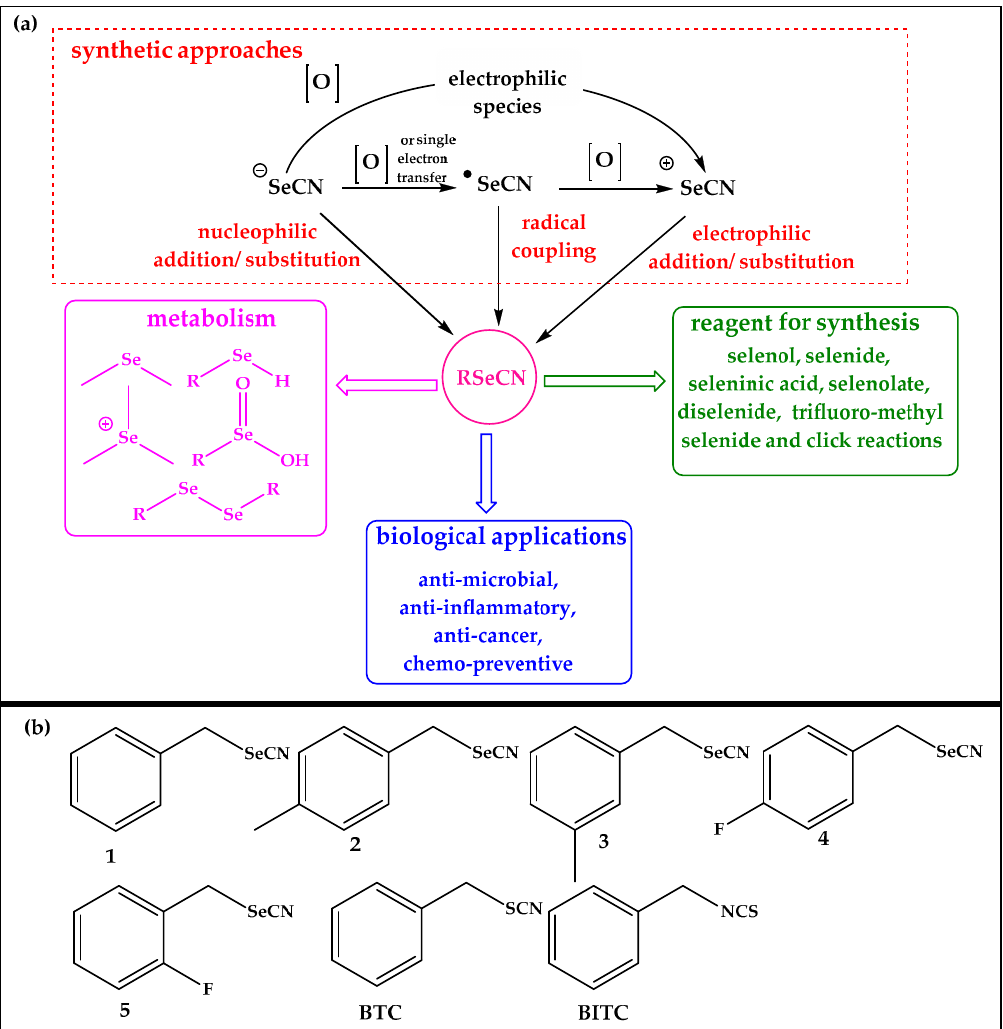
Figure 1. Panel ( a ) represents various approaches to synthesize RSeCN, which include not only electrophilic or nucleophilic addition and substitution reactions but also radical coupling reactions. Once produced, these multifunctional agents may be exploited for the generation of other RSeS. The metabolism of selenocyanates also leads to the formation of seleninic acid and diselenide, along with dimethyl selenide and trimethyl selenonium ions. RSeCN provide several important biological applications. Panel ( b ) represents the structures of compounds employed in this study.